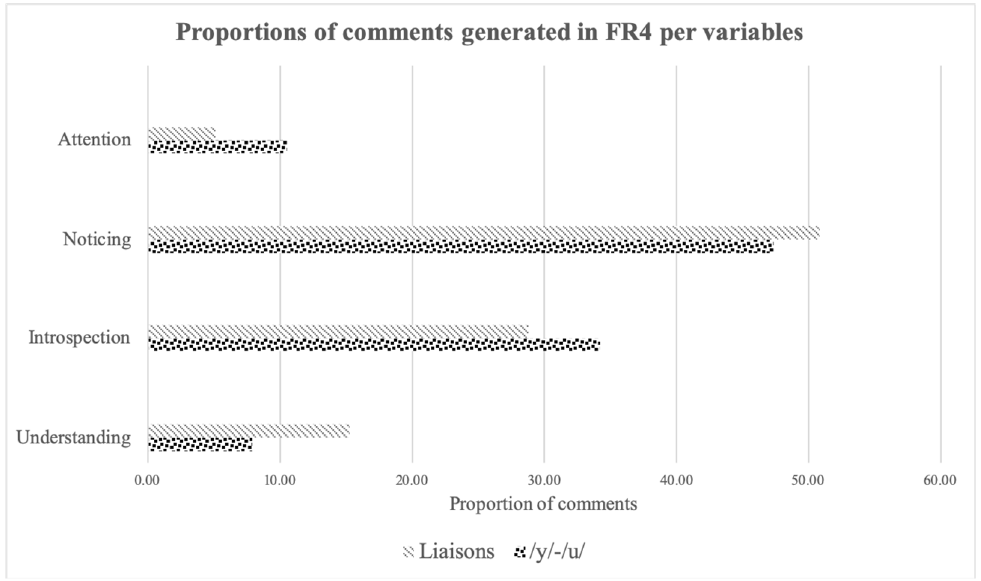
Figure 6. Proportions of comments generated in FR4.